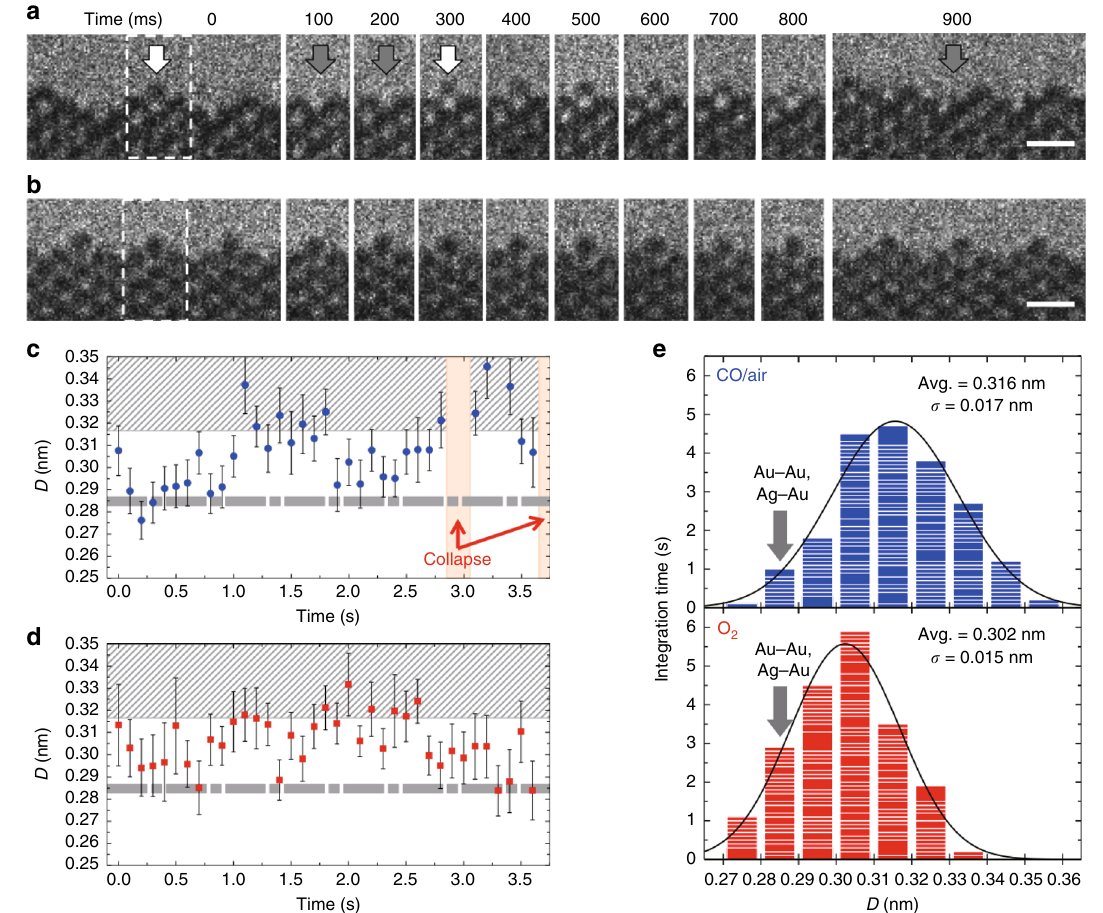
Fig. 2 Dynamic nature of a self-activating nanofacet on {110}. A nanofacet being a dynamic in CO/air (1 vol.% CO/air, 100 Pa) and b stable in O 2 (100% O 2 , 100 Pa). Images are taken from in situ environmental transmission electron microscopy (ETEM) movies (frame rate: 40 fps) (Supplementary Movies 1 and 2). In a , white arrows indicate the top atomic column of the nanofacet, and gray arrows at 100, 200, and 900 ms indicate the absence of atoms at the top atomic column, or displaced to an adjacent site (out of view) (Supplementary Movie 1). Note that the image contrast of the top atomic column varied with time (from 400 to 800 ms) (see also Supplementary Note 4). Time-dependent distances between the top atomic column and the atomic column immediately below, D in c CO/air and d O 2 . D was evaluated by Gauss fi tting for intensity pro fi les of ETEM images (Supplementary Note 2). The fi tting errors are shown as error bars. In c , d , dotted bars represent the range of D in pure gold and Au – Ag nanofacet models without oxygen, while shaded areas represent those Au – Ag nanofacet models with oxygen (or Au – AgO models). e Distribution of D for time intervals of 100 ms in CO/air and O 2 . Arrows in e indicate the corresponding distance between Au and Au atomic columns in pure crystalline gold surfaces ( D Au = 0.288 nm) and that between Au and Ag atomic columns in the nanofacet models ( D = 0.2842 – 0.2849nm) (Supplementary Note 5). In a , b , ETEM images at 0 and 900 ms are shown in full size, and those from 100 – 800ms are shown partially in the area between the dotted lines at 0 ms. The image contrast and frame rate in Supplementary Movies 1 and 2 were adjusted with 4 × 4 × 4 binning. Scale bars: 0.5